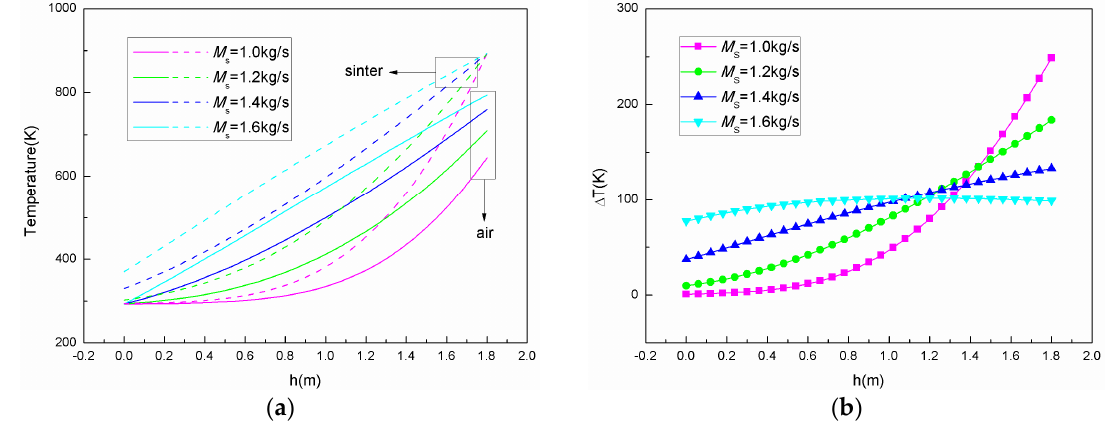
Figure 11. ( a ) The average cross-sectional temperature distribution of air and sinter; ( b ) the temperature differences between sinter and air along the height of the sinter bed layer of different sinter flow rates.